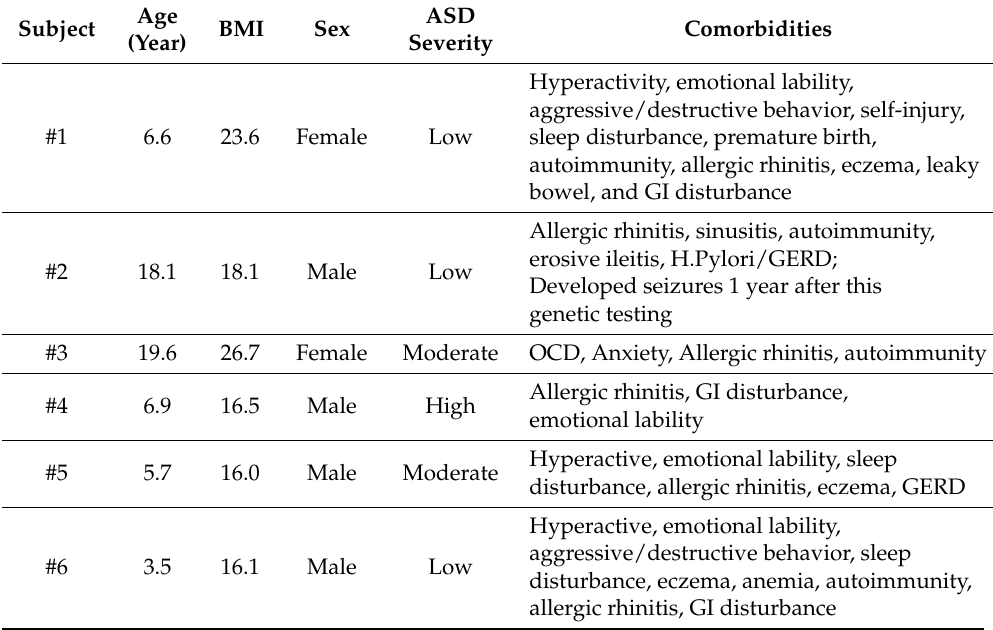
Table 2. Overview of subject demographics and